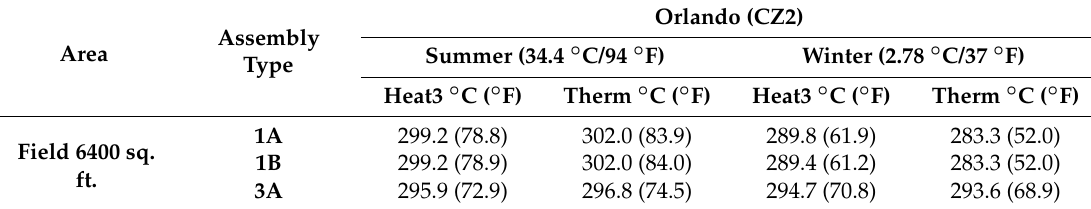
Table 9. Difference in metal deck temperatures between HEAT3 (3D) and THERM (2D) Analysis in case of Orlando (CZ2).